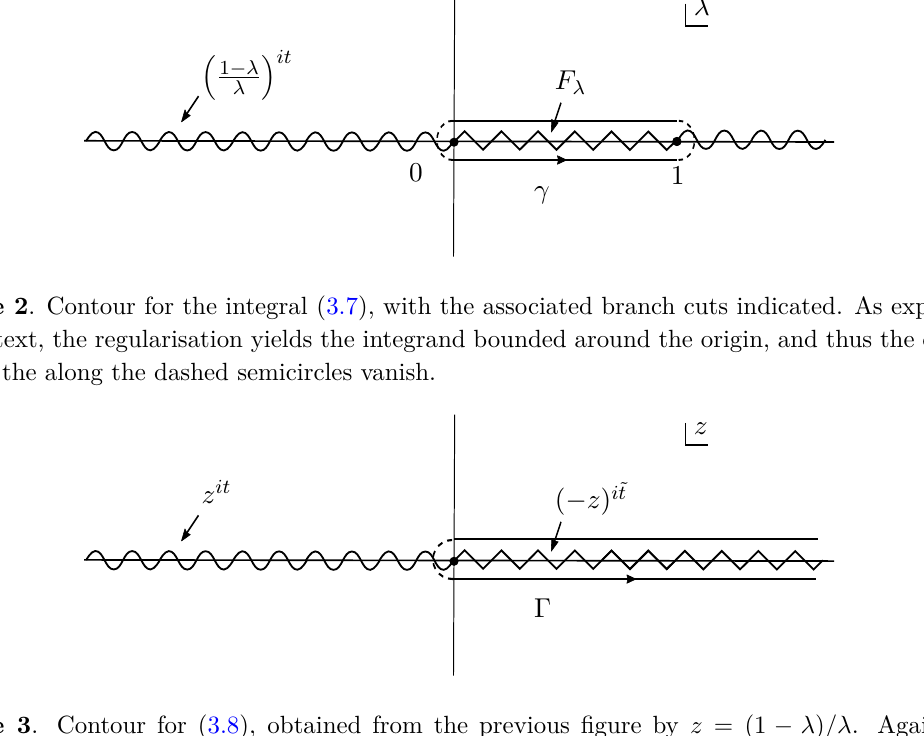
Figure 3 . Contour for (3.8), obtained from the previous figure by z = (1 − λ ) /λ . Again, the contribution of the dashed segment vanishes when properly